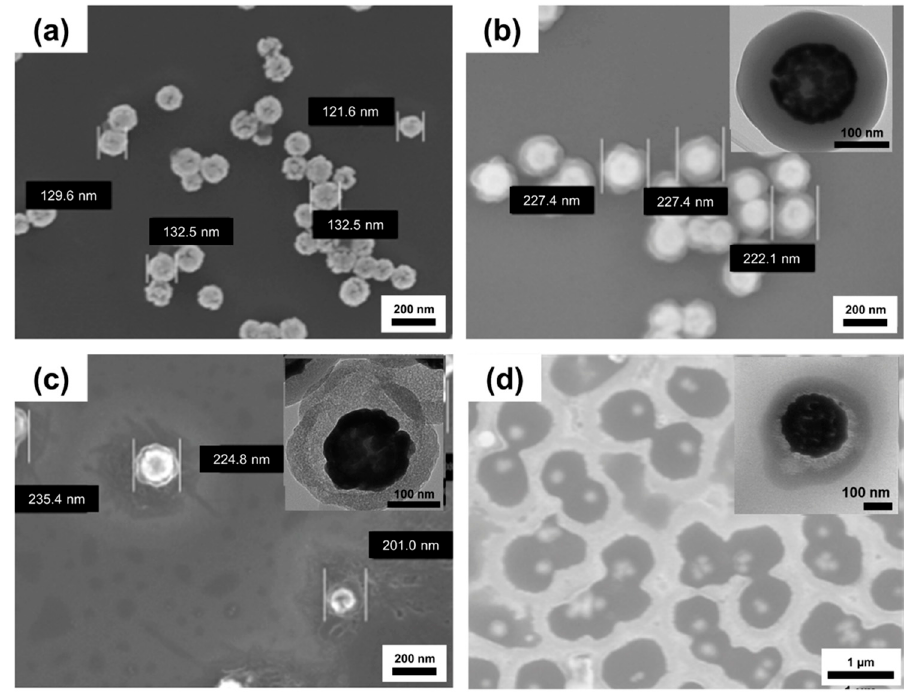
Figure 1. Field emission scanning electron microscope (FE-SEM) images of ( a ) GNSs (140 nm) × 100 K; ( b ) GNS@SiO 2 (~240 nm) × 100 K; ( c ) GNS@ m -SiO 2 (~240 nm) × 100 K; and ( d ) GNS@ m -SiO 2 @hydrogel (~550 nm) × 30 K. TEM images for the ( b ) GNS@SiO 2 × 100 K; ( c ) GNS@ m -SiO 2 ×